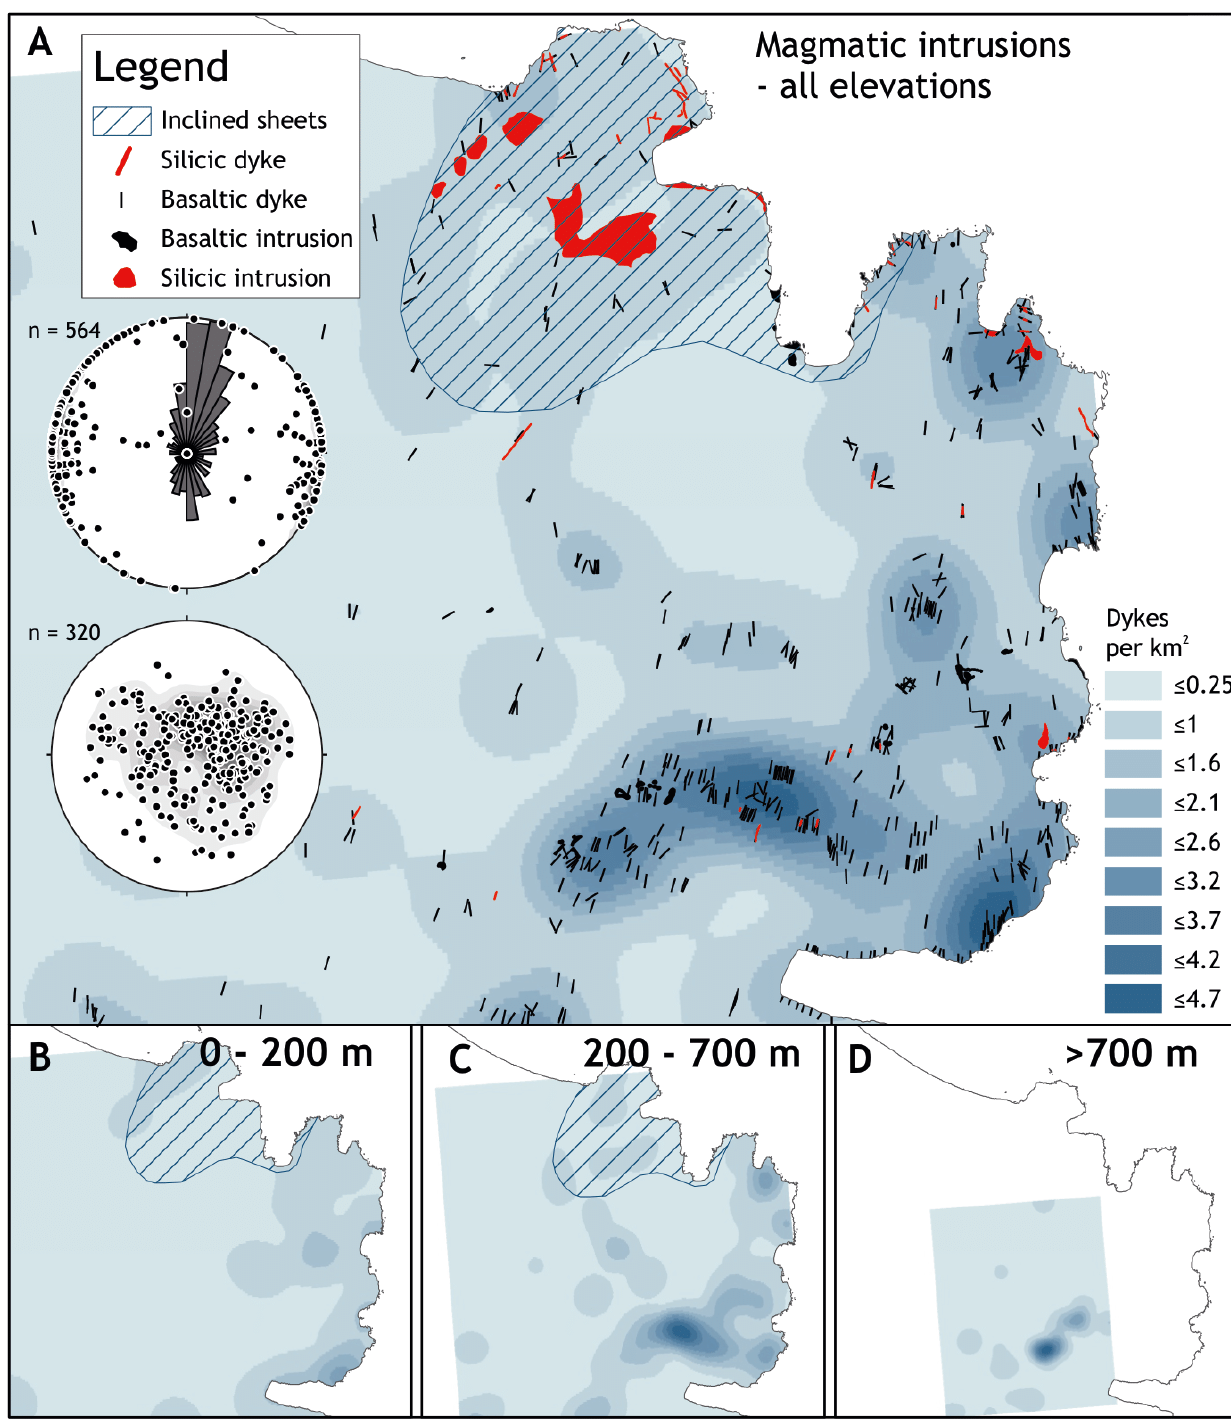
Figure 11: Density and distribution of magmatic intrusions in BEL at [A] all elevations, [B] 0–200 m, [C] 200–700 m, and [D] above 700 m above sea level. [A] Stereographic projections of sheet intrusion orientations in equal area lower hemisphere plots: Upper plot: poles to planes of the 564 sheet intrusions displayed in the map in [A]. The rose plot and Kamb contour plot show a clear preference of sheet intrusions to strike NNE. Maximum density in Kamb contour plot = 90. Maximum bin of Rose plot contains 23 % of all measurements. Data: this study. Lower plot: poles to planes of 320 inclined sheets measured in the shaded area in [A]. The Kamb contours indicate a small circle distribution of inclined sheet orientations with a slight preference for sheets to dip towards the SE. Maximum density in Kamb contour plot = 28. Data from Burchardt et al.